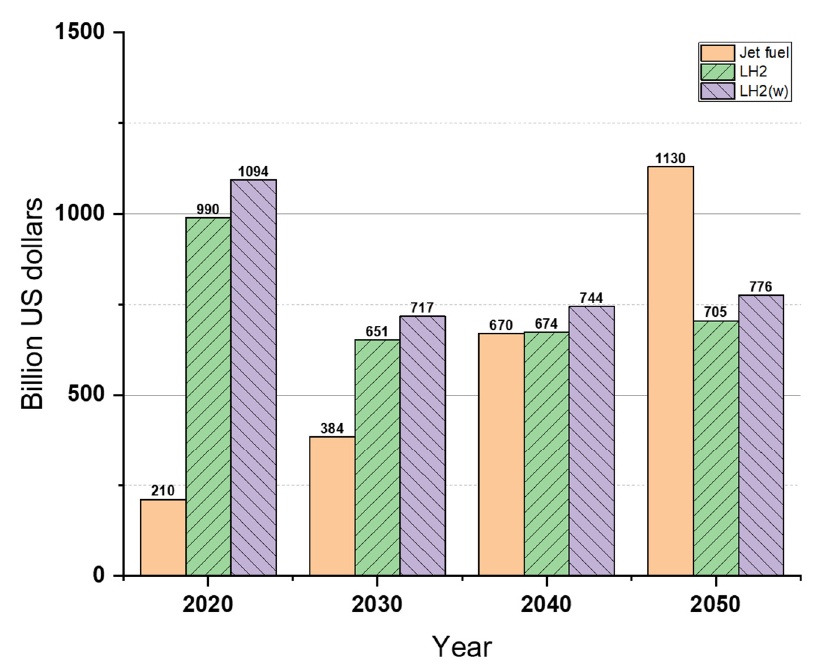
Figure 10. Total estimated annual fuel cost trend.